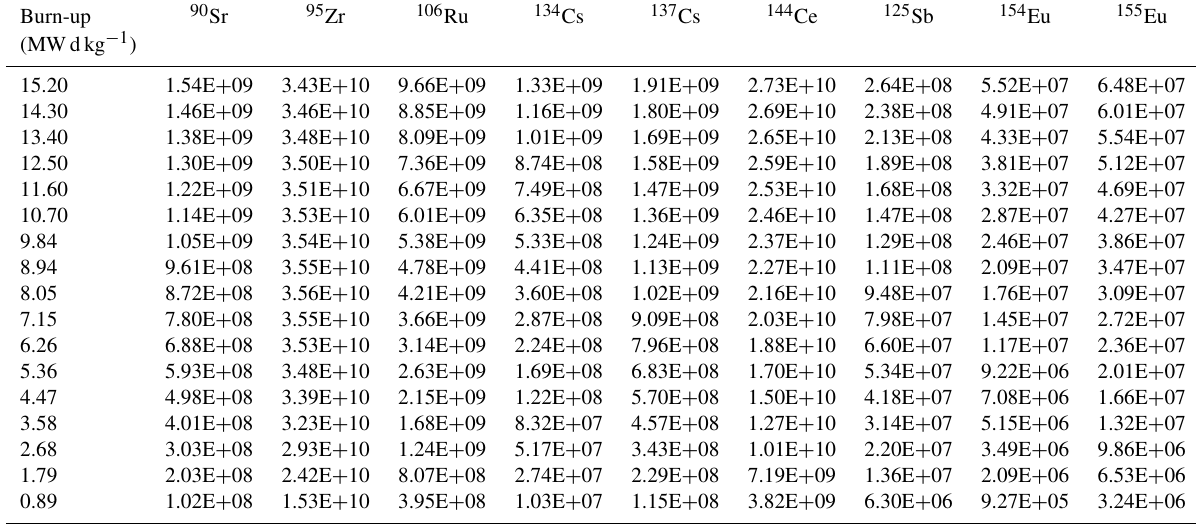
Table 3. The activity concentrations of radionuclides in the ChNPP fourth unit nuclear fuel with different burn-up, Bqg − 1 .